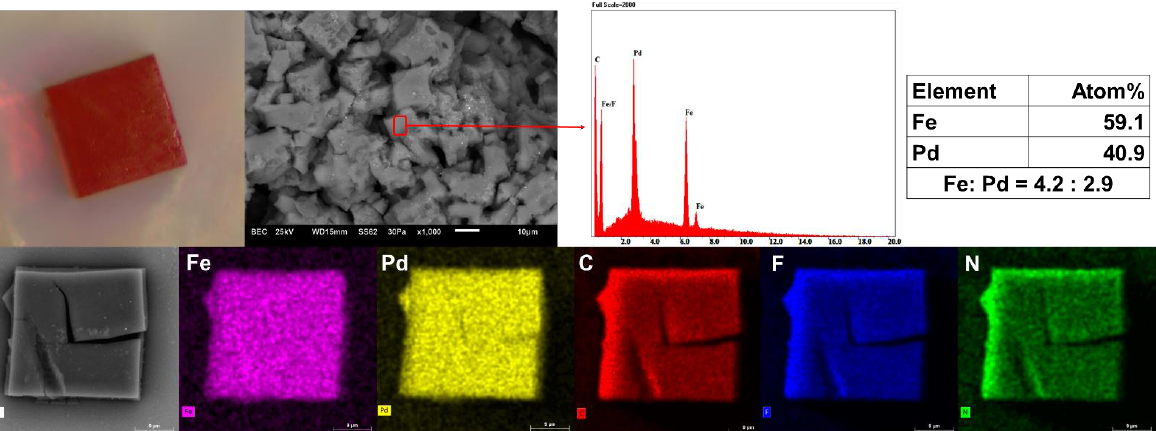
results for each element (Fe: pink, Pd: yellow, C: red, F: blue and N: green) demonstrate that the